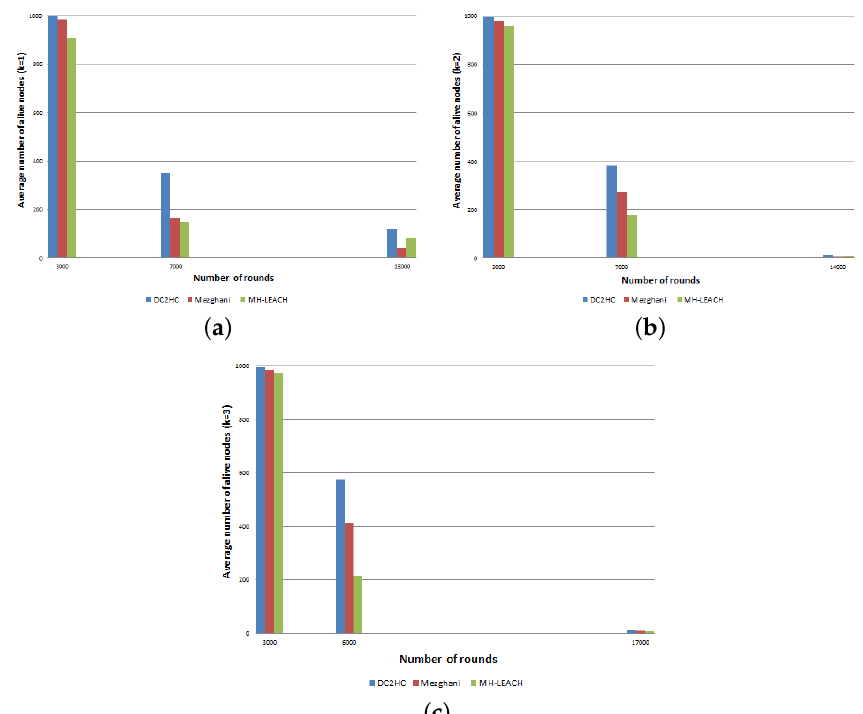
Figure 17. Average number of alive nodes over execution time with δ = 1000 deployed nodes and ( a ) k = 1, ( b ) k = 2, ( c ) k =